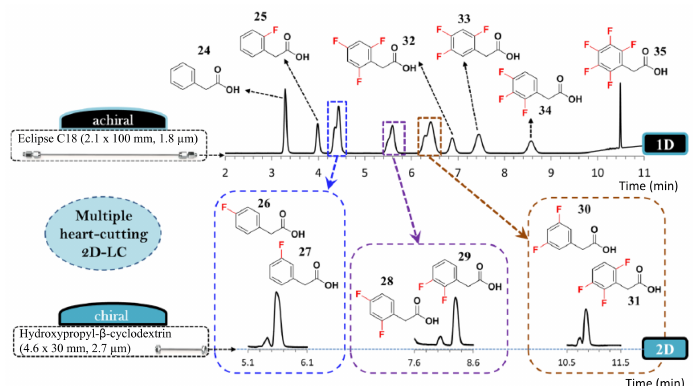
Figure 2. Multiple heart-cutting 2D-LC method for separation of a complex mixture of fluorophenylacetic acid isomers. Flow rates employed were F v = 0.5 mL/min for the first achiral dimension and 1 mL/min for the second chiral one. Modified with permission from ref.